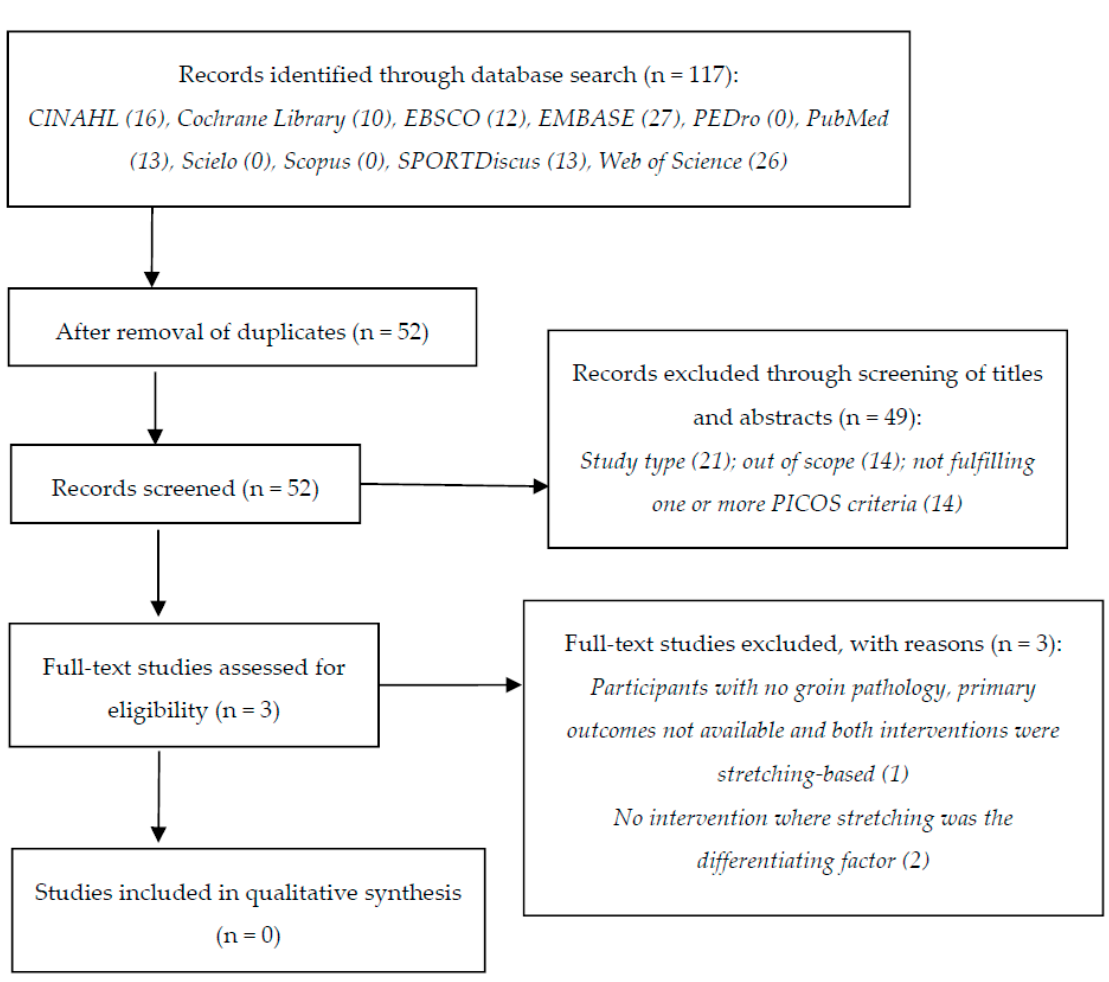
Figure 1. Flowchart describing the study selection process.